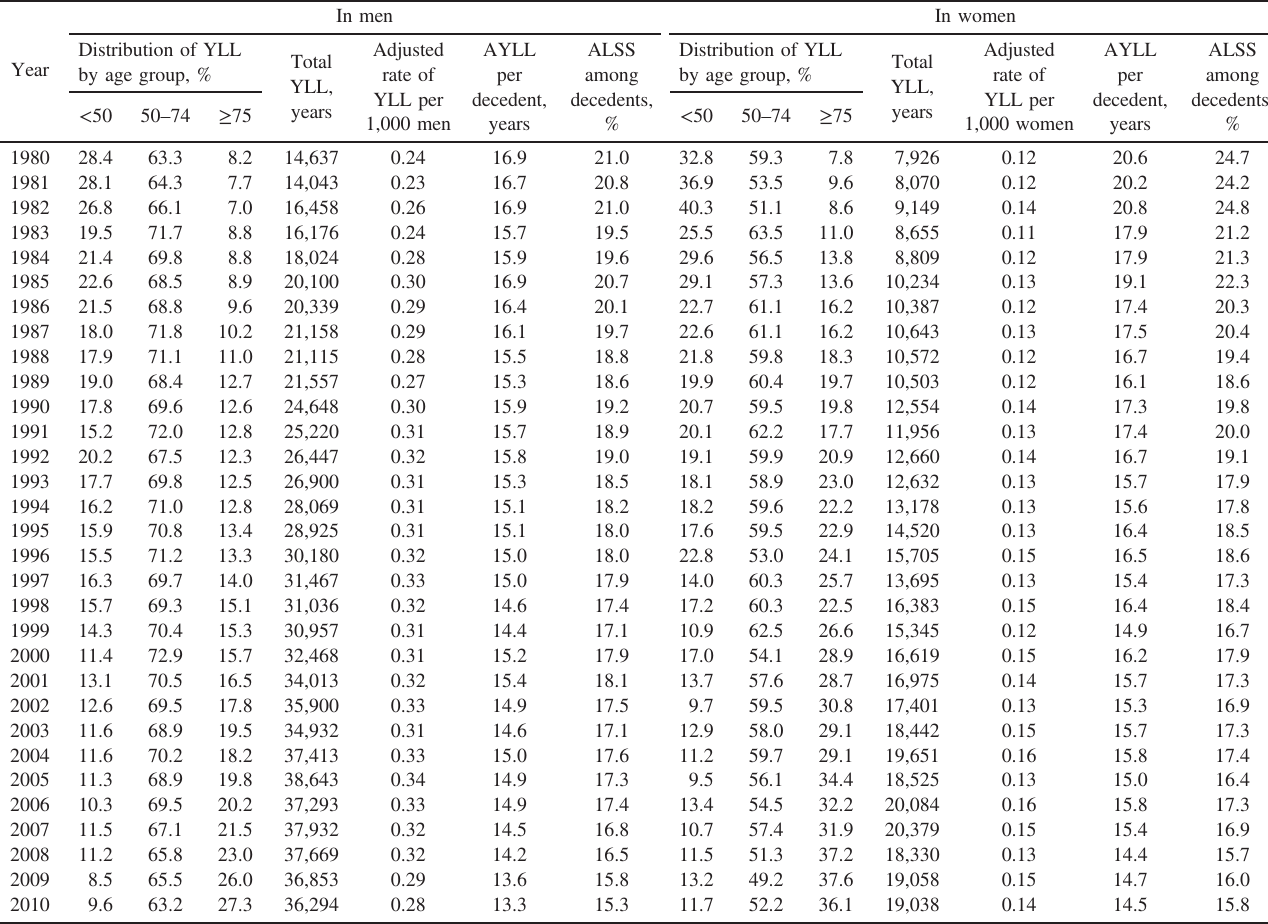
Table 3. Total years of life lost (YLL), adjusted YLL rate a , average years of life lost (AYLL), and average lifespan shortened (ALSS) due to kidney cancer in Japan, 1980 – 2010 In men In women Distribution of YLL Total Year by age group, % YLL, 1980